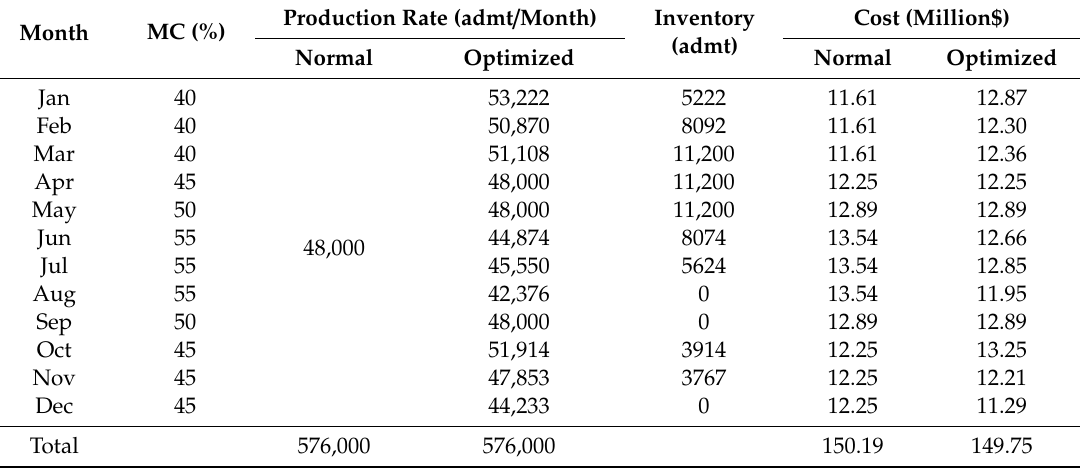
Table 2. Comparison between normal and optimized annual